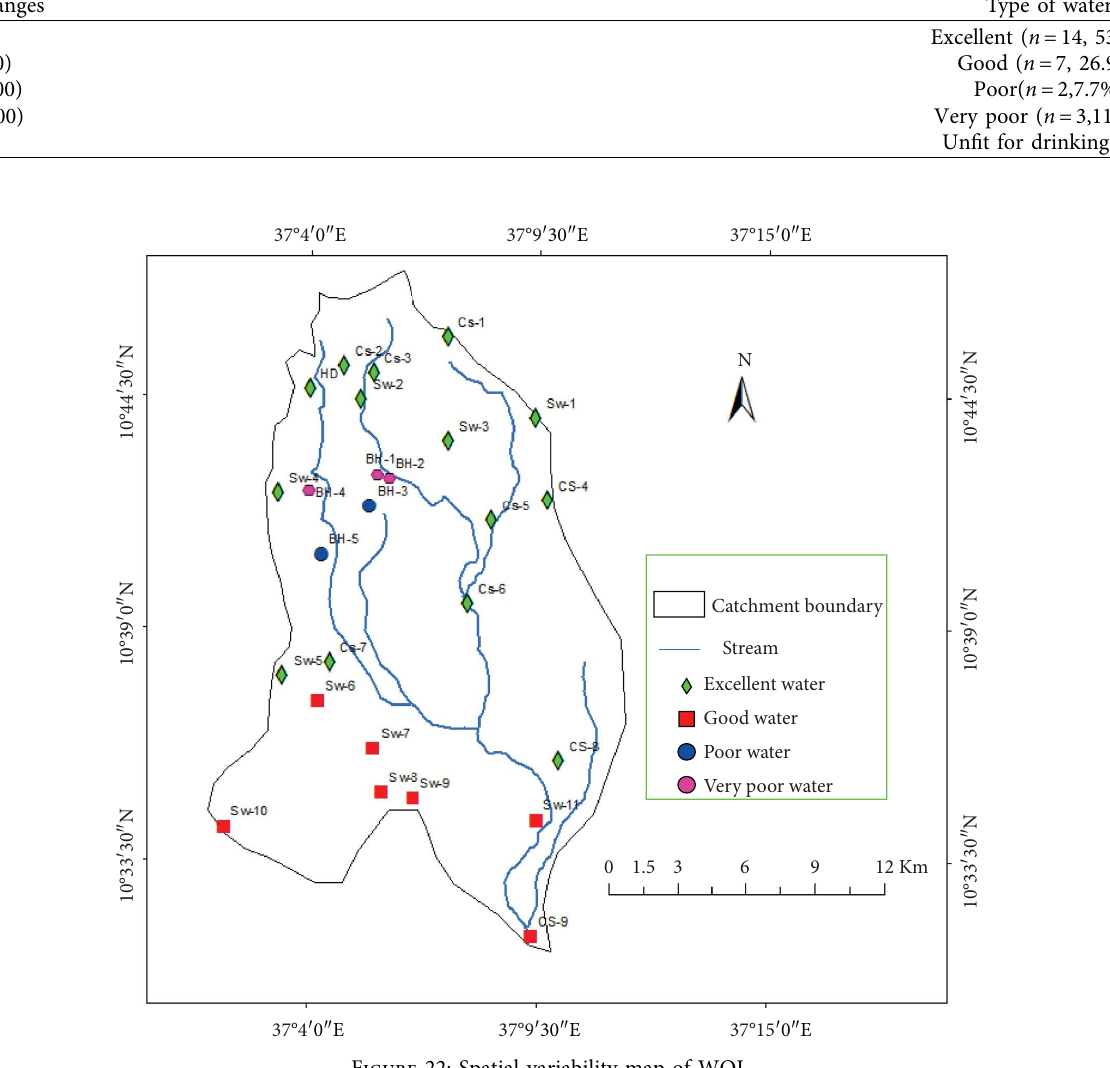
Table 6: Classifcation and categorization of computed WQI values for human consumption [41]. WQI ranges